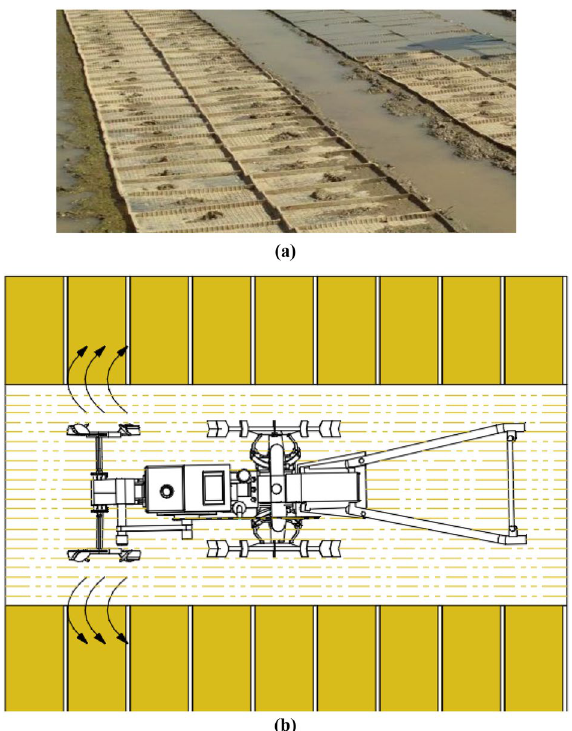
Figure 1. Working background of the paddy field pulper. ( a ) Rice nursery environment. ( b ) Simple diagram of paddy field pulper